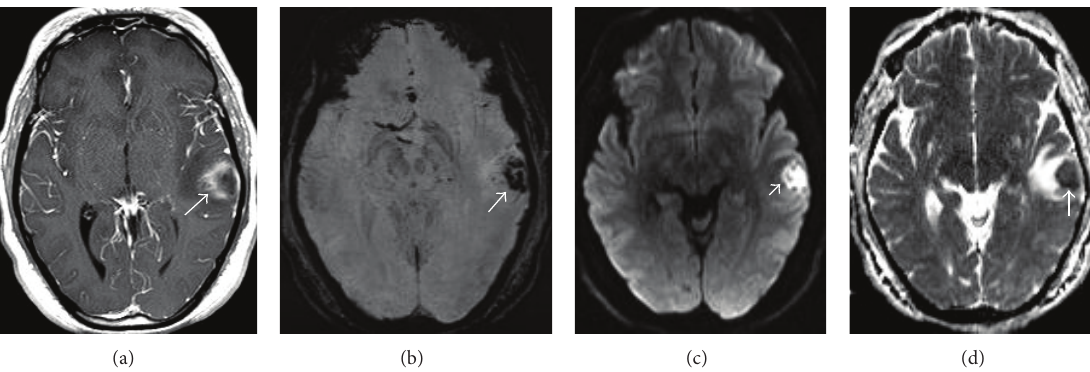
Figure1:(a)PostgadoliniumaxialT1SEimageshowstheringenhancingwallofthelefttemporalabscess(arrow).Notethelackofsmoothring enhancement. (b) Susceptibility weighted image shows prominent hypointense signals (arrow) in the lesion. (c) Diffusion image demonstrates bright signals due to restricted diffusion from the pus in the center of the abscess (arrow). (d) Apparent diffusion coefficient (ADC) map shows corresponding dark signals confirming true restricted diffusion